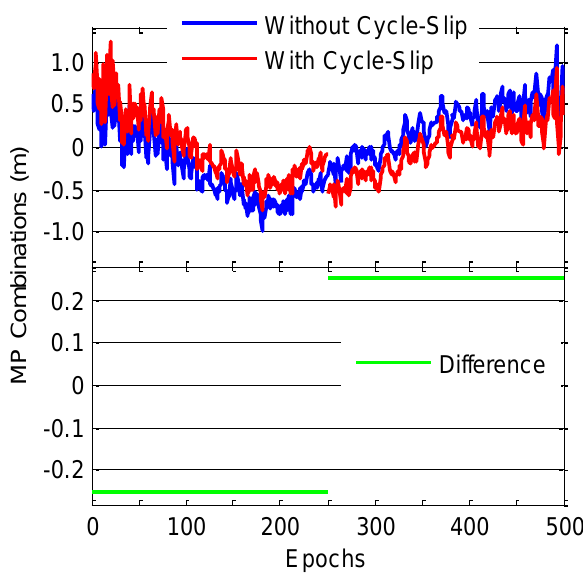
Figure 2. MP combination time series of B1 signal with and without cycle slips at 500 consecutive epochs for BDS-2 MEO satellite C12 at station SGG1 on 13 July 2016.